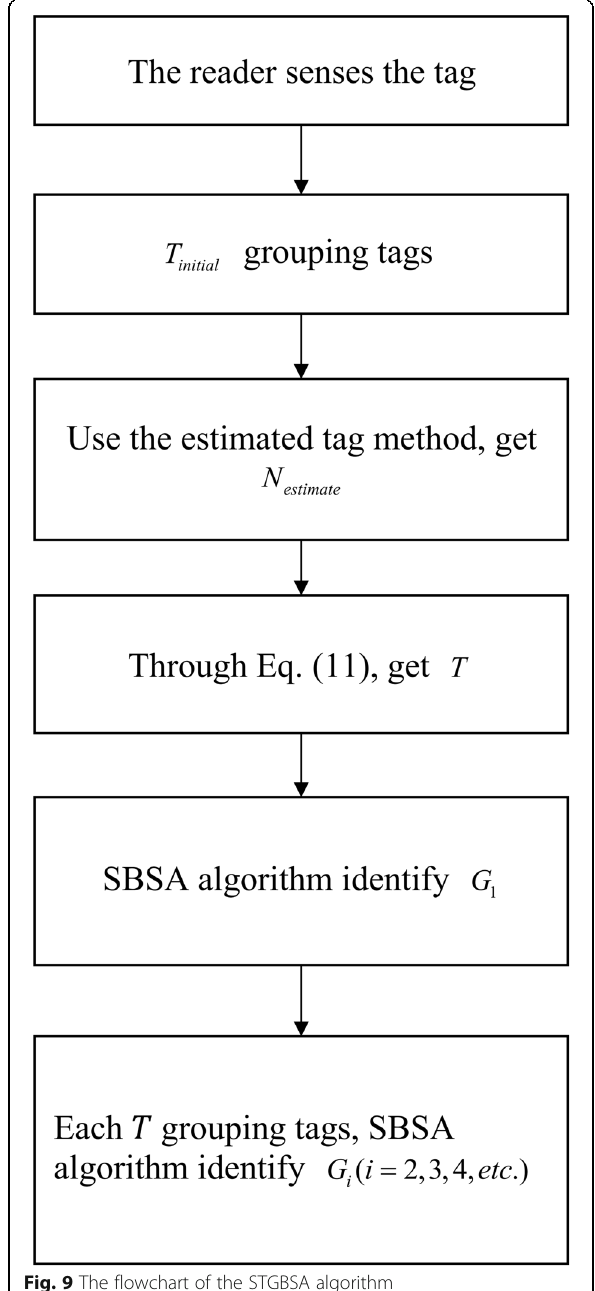
Fig. 9 The flowchart of the STGBSA